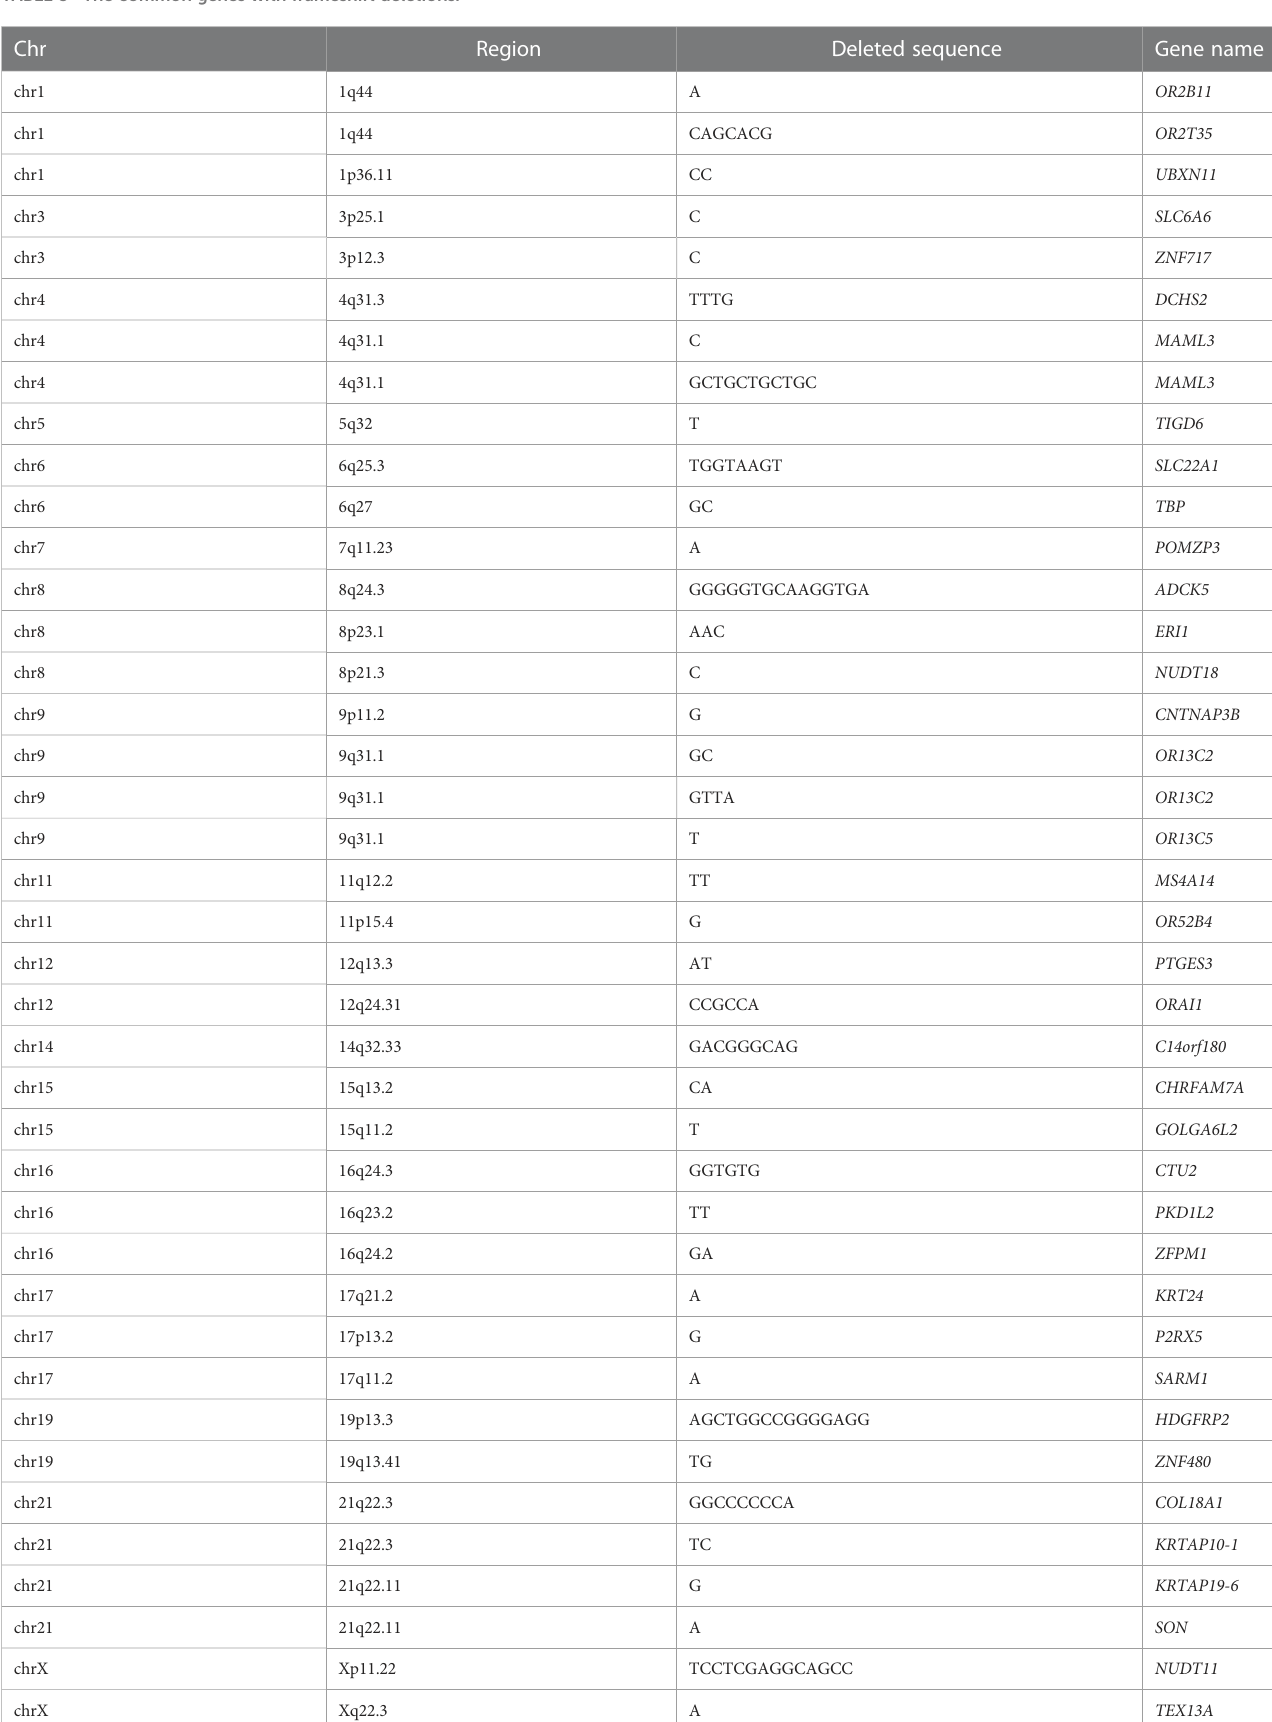
TABLE 3 The common genes with frameshift